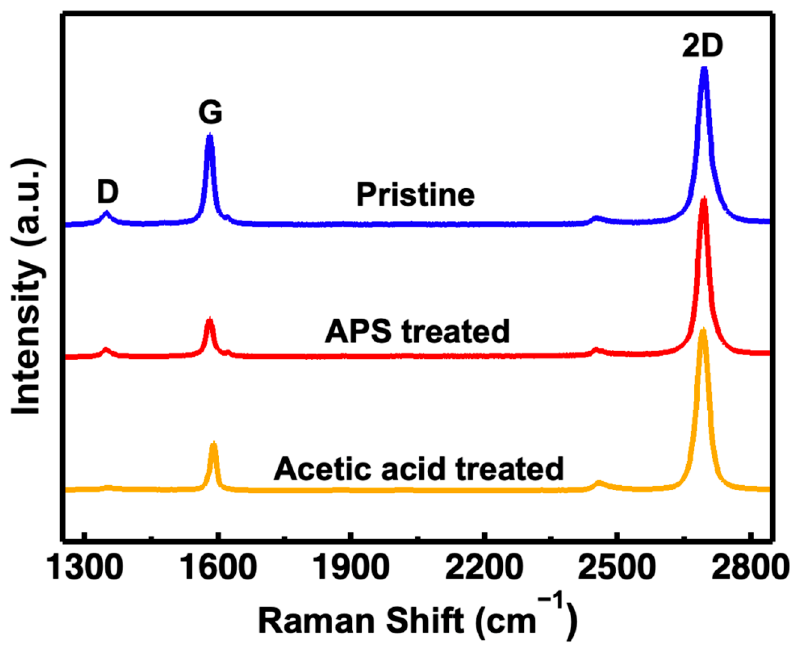
Figure 5. Raman shift of the three kind of graphene on SiO 2 /Si substrate.